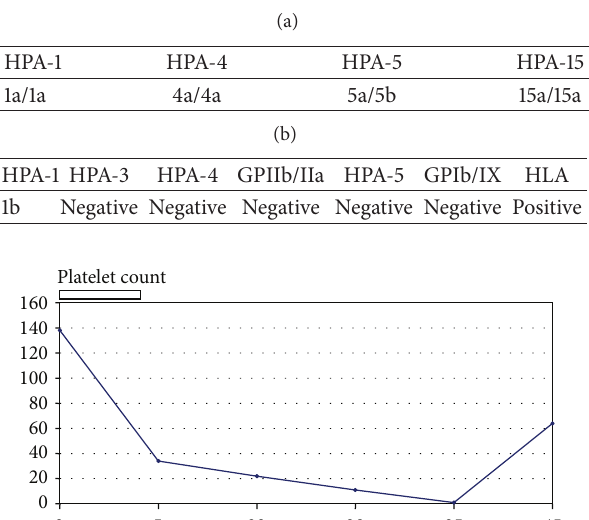
Table2: (a)Platelettypingresults(SSP).(b)Plateletantibodyscreen results (ELISA).